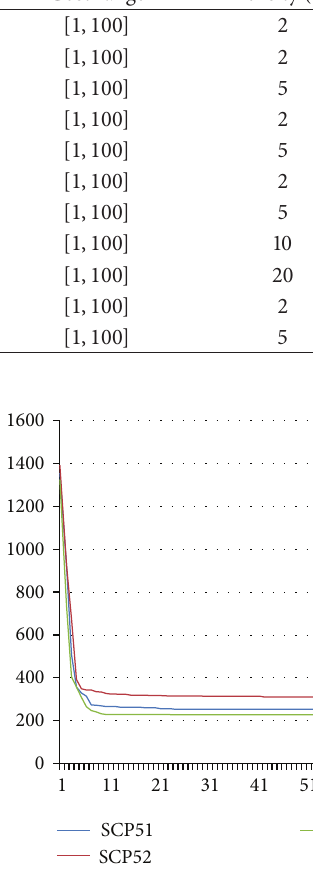
Figure 2: Convergence analysis to a better solution (benchmarks: SCP41, SCP42, and SCP43).